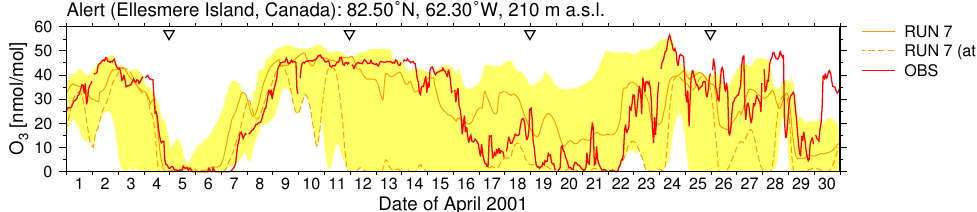
Fig. 7. The same as Fig. 3a but for simulated surface ozone mixing ratios at the nearest and surrounding grid cells to Alert from Run 7 (orange solid/dashed lines and yellow